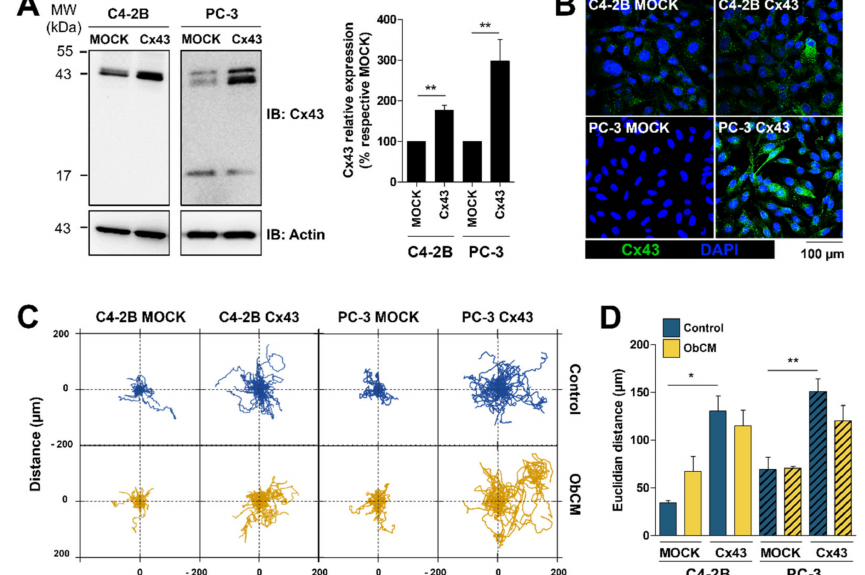
Figure 5. Impaired membrane targeting of Cx43 prevents osteoblasts-dependent migration in two other human prostate cancer (PCa) cell lines. ( A ) Representative immunoblots and densitometric quantification of Cx43 in PCa cells stably transfected to overexpress Cx43. Data represent the mean ± SEM from 7 (C4-2B) or 4 (PC-3) di ff erent experiments. ( B ) Immunostaining of Cx43 (green) in C4-2B and PC-3 MOCK and Cx43 cells (green); nuclei were DAPI-stained (blue). ( C , D ) quantitative analysis of single cell migration of C4-2B and PC-3 cells using time-lapse videomicroscopy. Cells were incubated for 17 h with either control media or osteoblasts-conditioned media (ObCM) and records were used for manual tracking of cell centroid trajectories. ( C ) Scaled spider graph showing for each condition and over 17 h of recording the individual paths of 15 representative cells, starting from their initial position at T = 0. ( D ) Euclidian distance ( µ m) has been measured and relative graph is shown. The values represent the mean ± SEM from 3 di ff erent experiments (C4-2B MOCK CTRL n = 49; ObCM-treated C4-2B MOCK n = 44; C4-2B Cx43 CTRL n = 79; ObCM-treated C4-2B Cx43 n = 91; PC-3 MOCK CTRL n = 78; ObCM-treated PC-3 MOCK n = 70; PC-3 Cx43 CTRL n = 98; ObCM-treated PC-3 Cx43 n = 119). * p < 0.05; ** p <